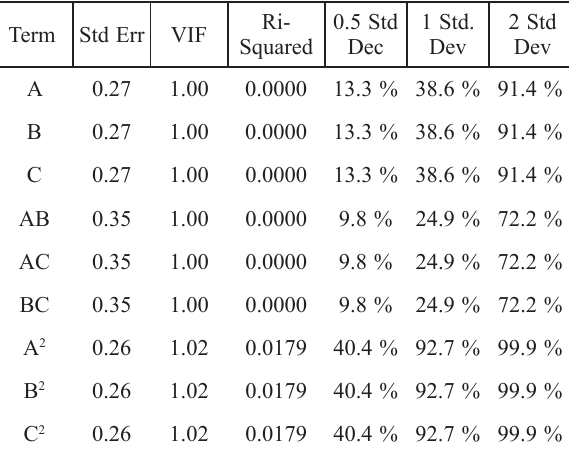
Table 5 – Design matrix evaluation for Response Surface Quadratic Model Term Std